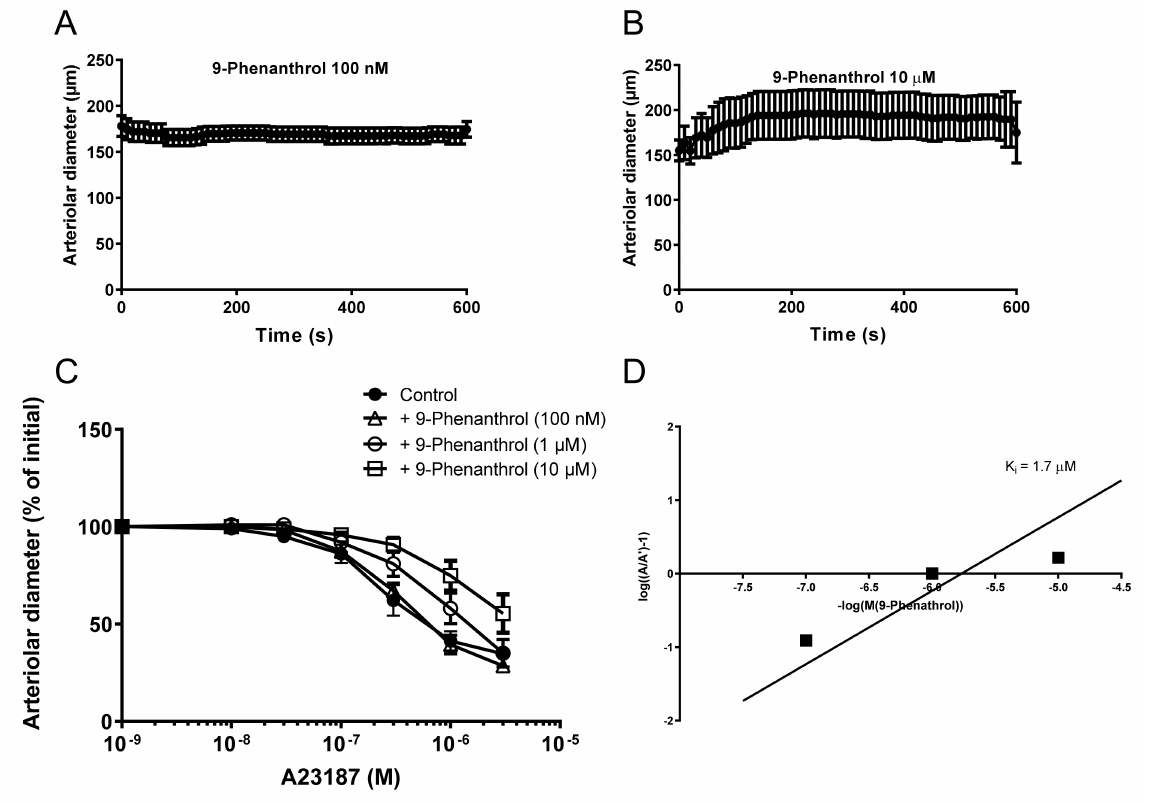
Figure 6. The Ca 2+ ionophore A23187 is a competitive agonist of TRPM4. Skeletal muscle ( m. gracilis ) arteries were isolated from the rat and the changes in vascular diameter were recorded upon 9- phenanthrol addition into the organ bath (Panel A , B , n = 5). Note, 9-phenanthrol had no effects at a concentration of 100 nM (maintained myogenic tone and vascular diameter, panel A ), while it resulted in a loss of myogenic tone (and in an increased diameter) at higher (shown at 10 µ M) concentrations (Panel B ). In individual arteries, the effects of 9-phenanthrol (applied concentrations are labeled) on A23187-evoked vasoconstrictions were also tested (Panel C ). The apparent EC50 values were plotted on a Schild plot (Panel D ) to yield the stability constant of 9-phenanthrol to bind to the A23187 binding sites in vascular preparations. Note, these results implicated a common receptor for 9-phenanthrol and A23187 (e.g., TRPM4) in this system. Twenty ( n = 20) animals were used for these